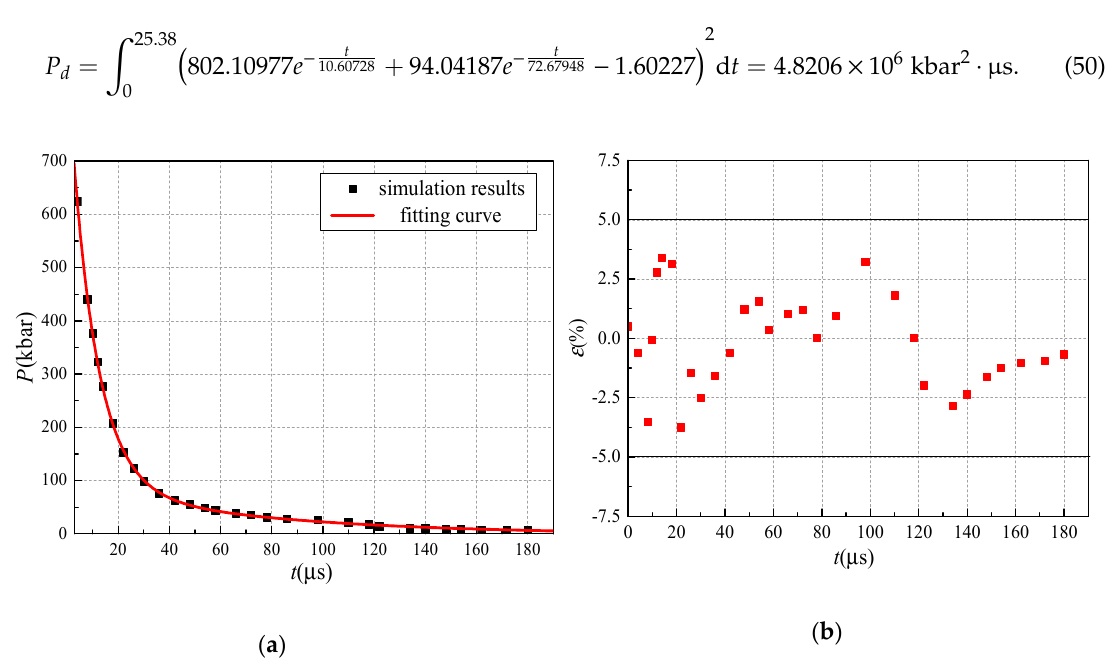
Figure 10. ( a ) Fitting curve of the peak pressures on the impact line; ( b ) Regular residuals between the pressure calculated by the fitting curve and the pressure obtained by simulation.